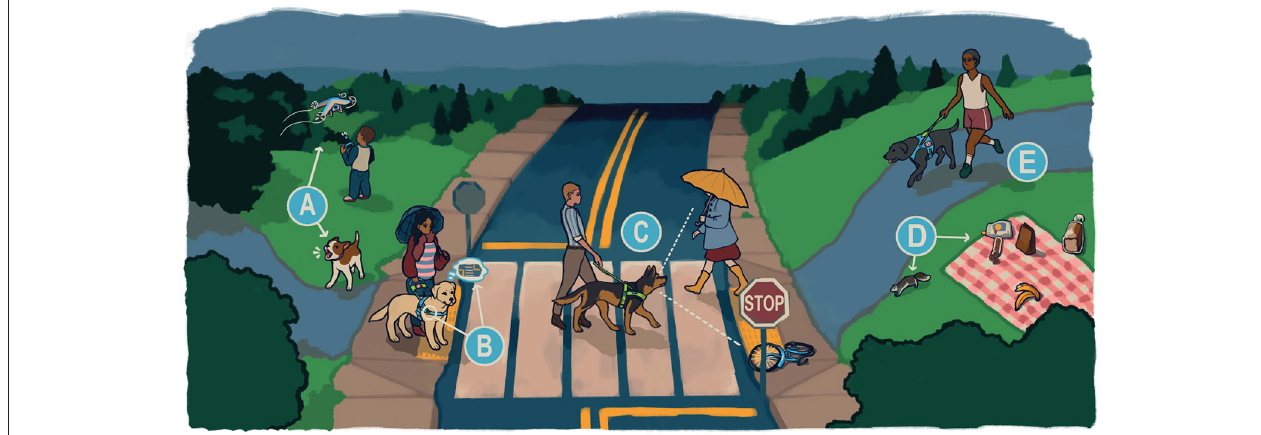
FIGURE 1 | Skills required of a high-performing guide dog. A high performing working dog is required to fulfill a demanding set of criteria that vary by working dog type. While some, such as resilience, are required for nearly all working dogs, other skills are job-specific. To illustrate this, we describe some of the major requirements for a guide dog, the working dog type bred by Guiding Eyes for the Blind. (A) A guide dog must not be frightened of or bark at things that typically alarm other dogs. When working, they must ignore distractions such as other dogs or other animals around them. (B) They must be comfortable leading out with a steady pace and pull when working in harness, while also remaining calm and focused in all situations. They must learn a wide range of commands, but also be able to ignore commands when they are not safe, and problem-solve when a command is not possible. (C) When there are obstacles or dangers in the handler’s path, a guide dog must alert the handler by stopping, or navigating their handler around the obstacles, and then resume walking in the target direction. When working, they should not be distracted by other people. (D) A guide dog must resist chasing things while working, and ignore enticing scents, including food. (E) A guide dog needs to be physically healthy, and matched to the stride and personality of their handler. Image credit: Kathleen